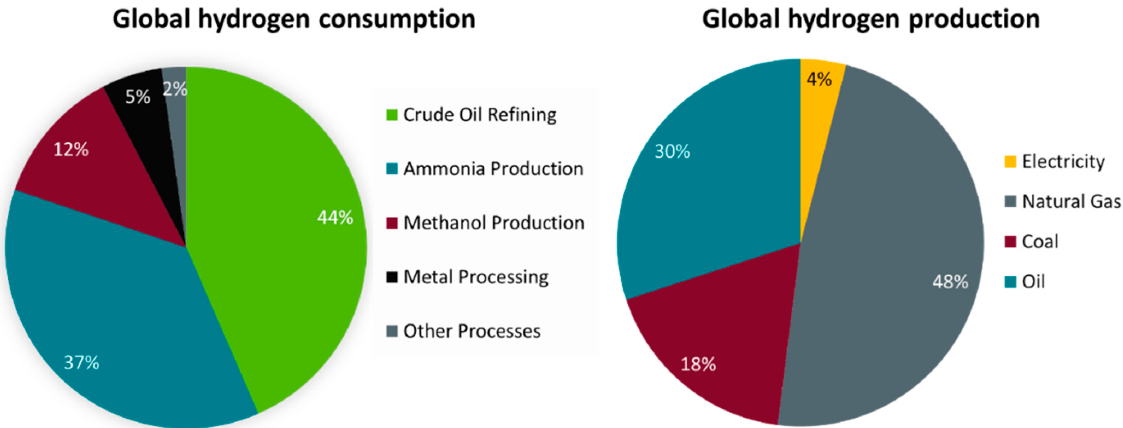
Figure 2. Shares of global hydrogen consumption and production. Left: share of the most important applications in modern global hydrogen consumption [6]; right: share of primary energy sources used for modern global hydrogen production [9].